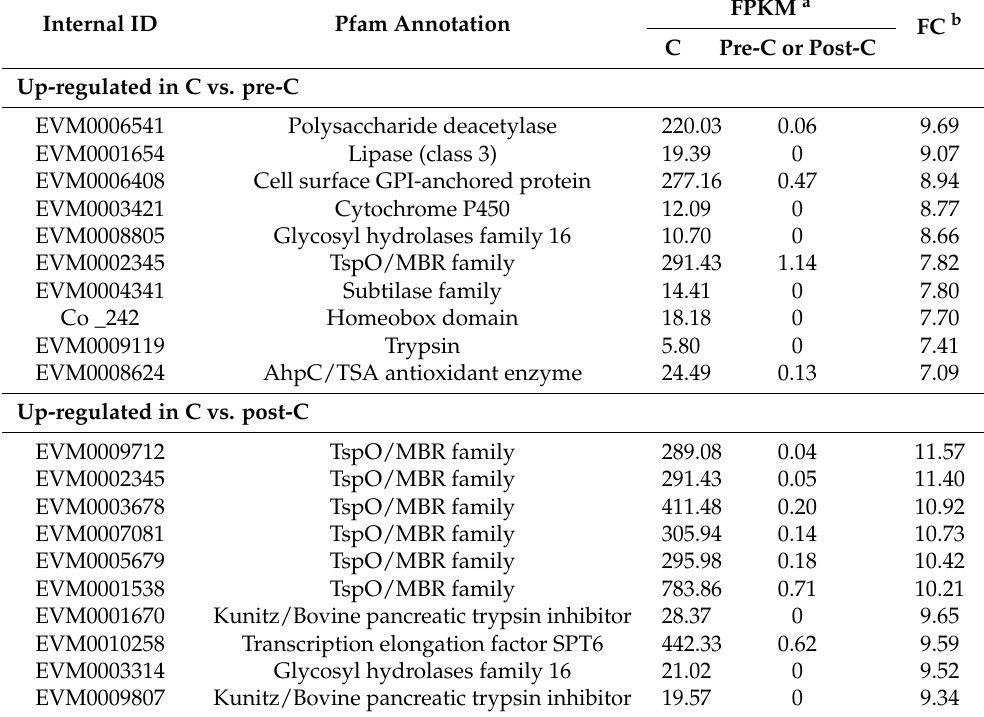
Table 2. Top ten up-regulated genes in the three conidiation